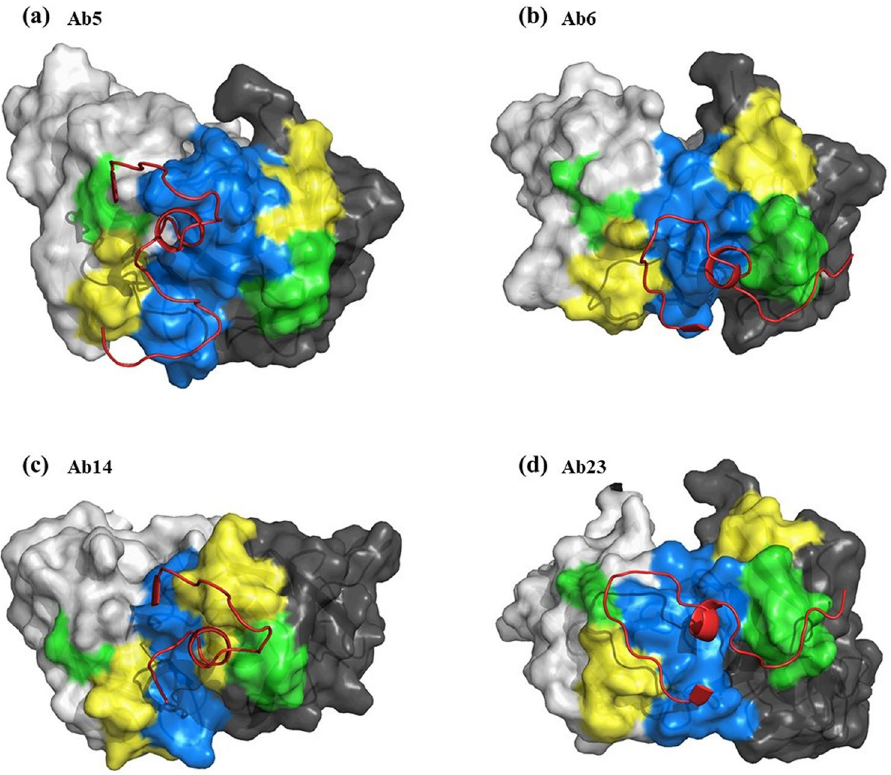
Figure 6. Surface presentation of the docked conformation of the antibody clones ( a ) Ab5, ( b ) Ab6, ( c ) Ab14 and ( d ) Ab23 with rNIE. VH and VL domains are in black and grey presentation with respective Yellow, green and blue represent CDR1, CDR2 and CDR3 respectively. Red ribbon is the rNIE residues that interacts with the antibody. Figure was prepared by PyMol ver 2.4.0 (https ://pymol